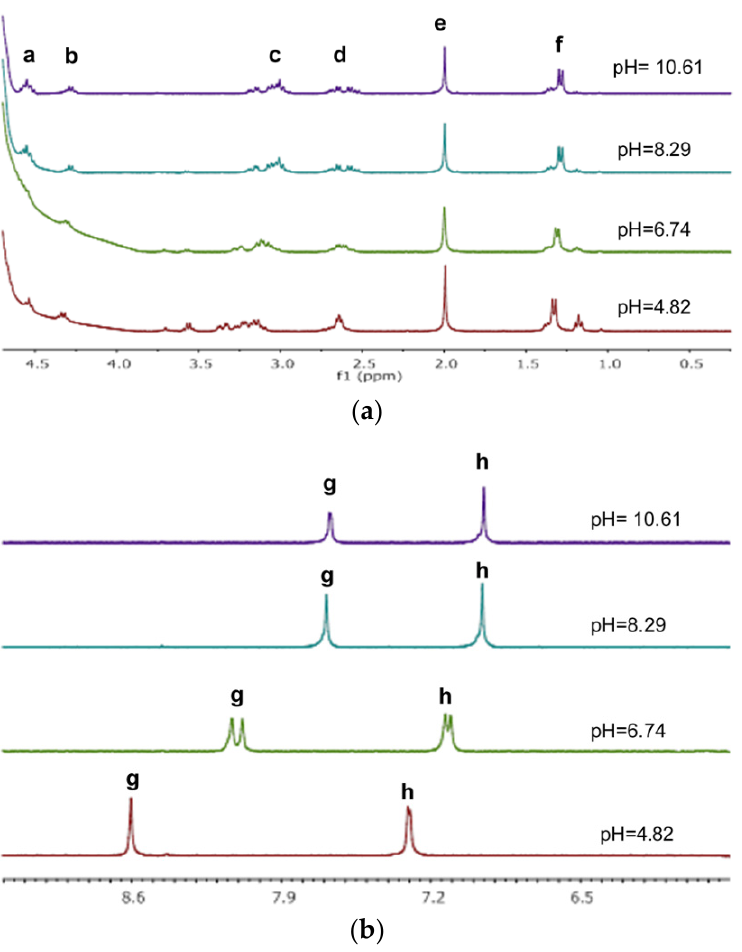
Figure A7. The aliphatic ( a ) and aromatic region ( b ) of the pH-dependent 1 H NMR spectra of Ac-HADH-NH 2 (c L = 5 mM): a: Asp H α , His(1),(4) H α ; b: Ala H α ; c: His(1),(4) H β ; d: Asp H β ; e: Ac-CH 3 ; f: Ala H β ; g: His (1),(4) H δ ; h: His (1),(4) H ε .